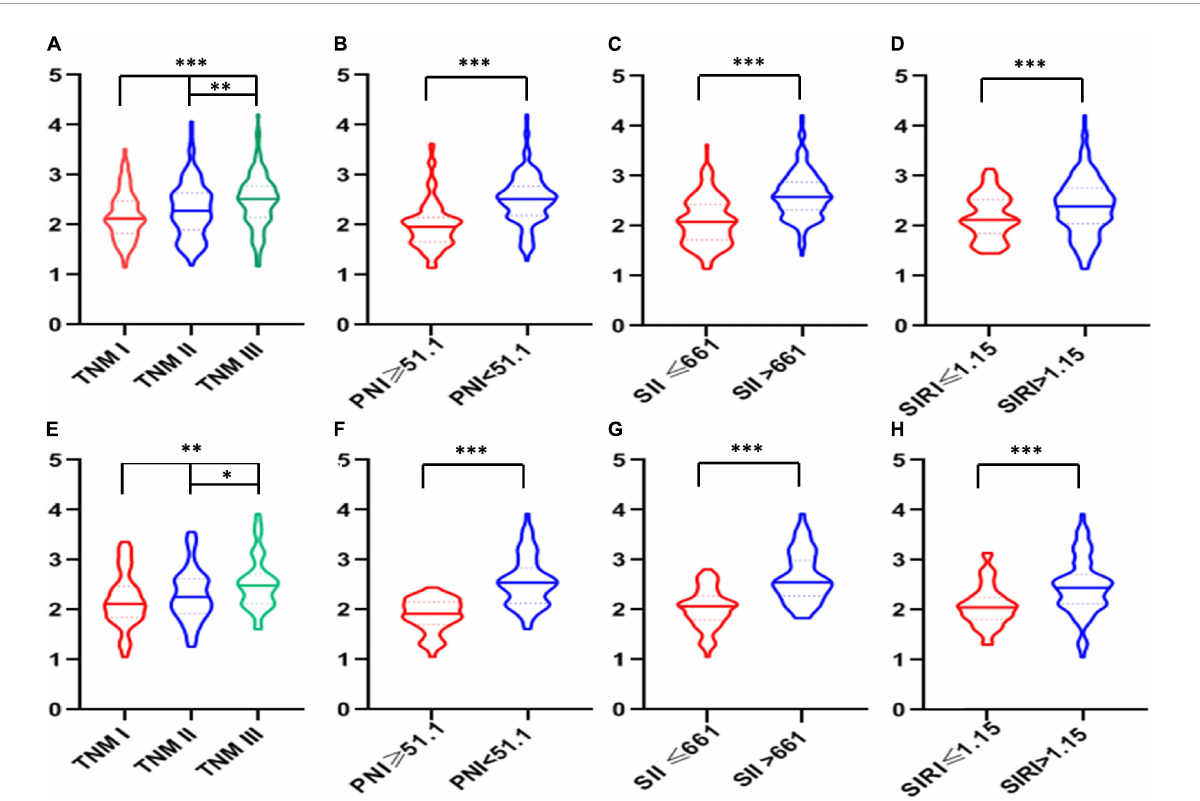
FIGURE5 The violin plots of integrative inflammatory and nutritional score (IINS) values. The violin plots of IINS grouped by tumor node metastasis (TNM), prognostic nutritional index (PNI), systemic immune-inflammation index (SII), and systemic inflammation response index (SIRI) in both training cohort (A–D) and validation cohort (E–H)